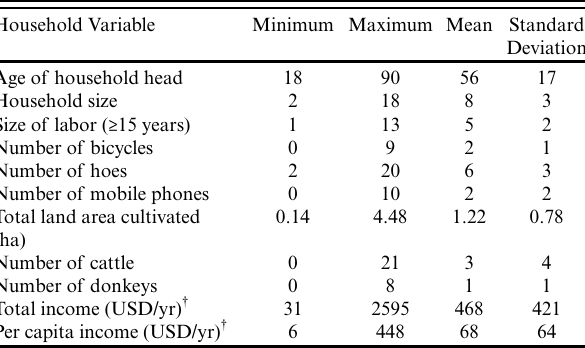
Table 1 . Descriptive statistics of households in the study area (source: 2013 survey).